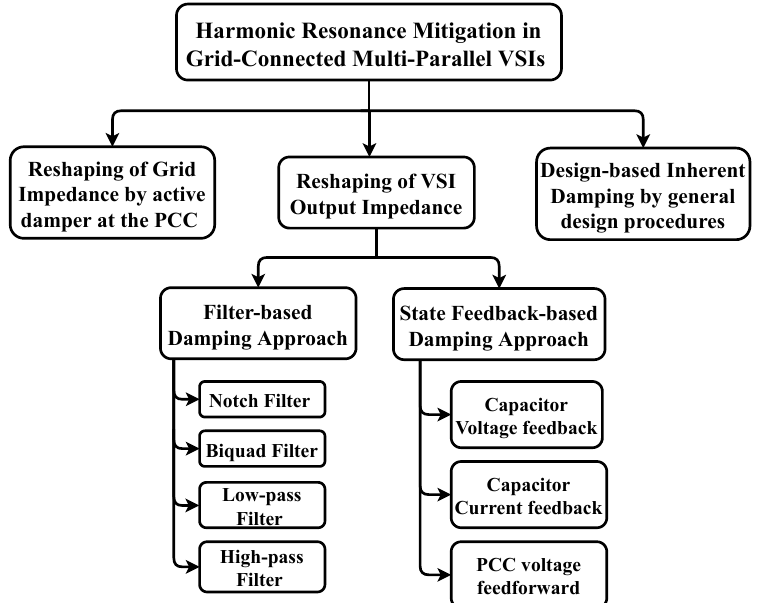
Figure 20. Different damping approaches for harmonic resonance mitigation in a multi–parallel inverter